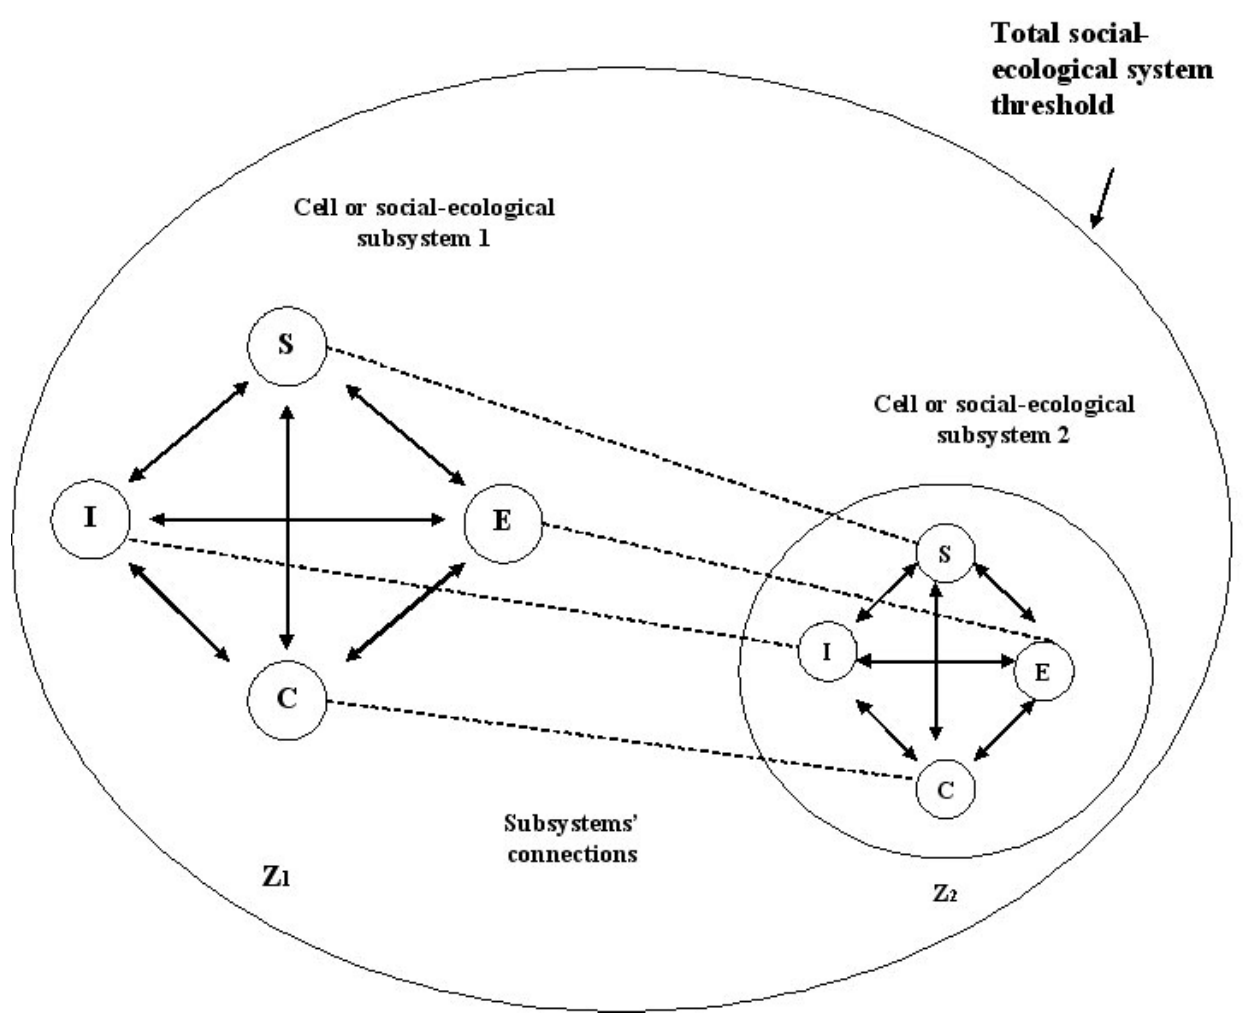
Fig. 3. Interrelationships between two social-ecological systems of reference with two different sizes, Z and Z , and their relation to their total system growth limits. In the World Cellular Model computer 2 interface that was applied to the Ebro River basin in Spain, each subsystem is related to an agent with a differentiated capacity to use water resources, process information, generate rules of behavior, and create social-ecological change in a co-evolutionary fashion (Tàbara 2003, Tàbara et al. 2006). S = structure and ruling institutions, E = energy and resources, I = information and knowledge, and C = social-environmental